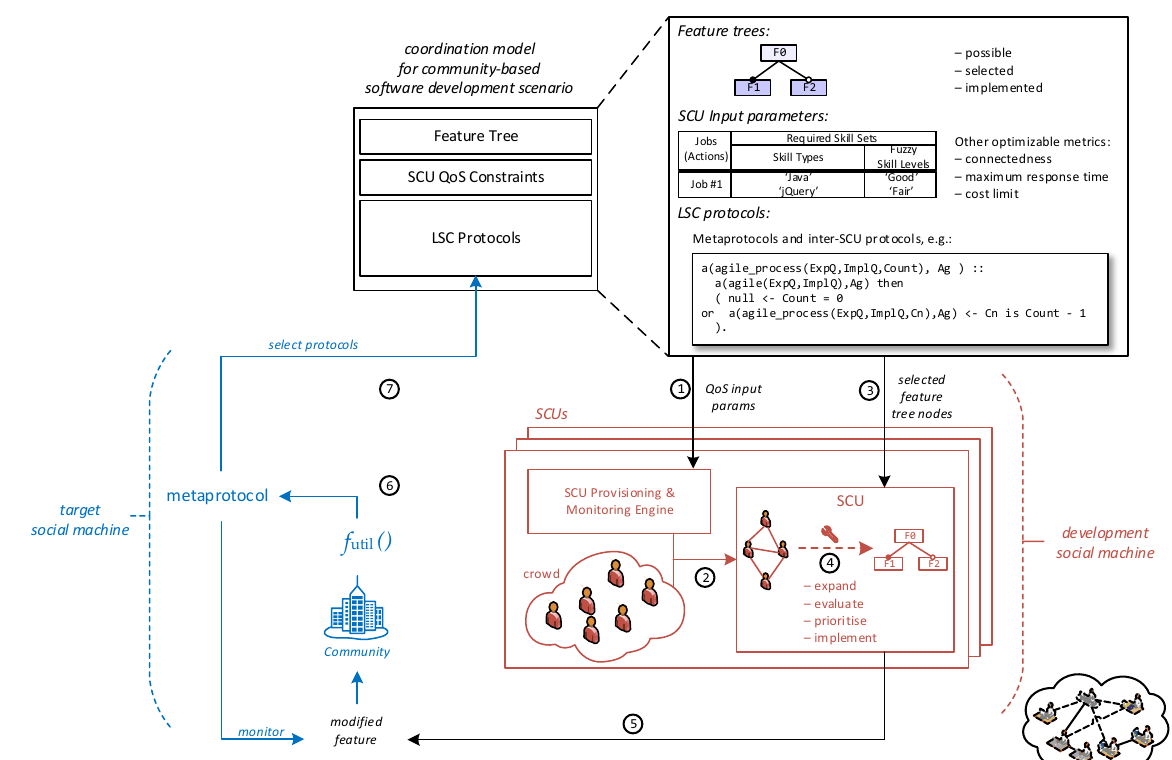
Figure 6. Using the Coordination Model to support the community-based, collaborative software development